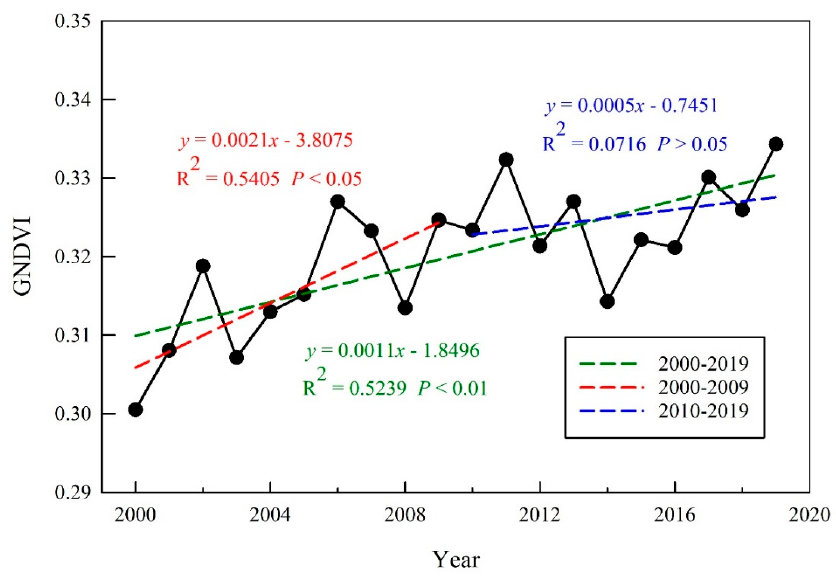
Figure 3. Interannual variation of the GNDVI on the QTP during 2000–2019.